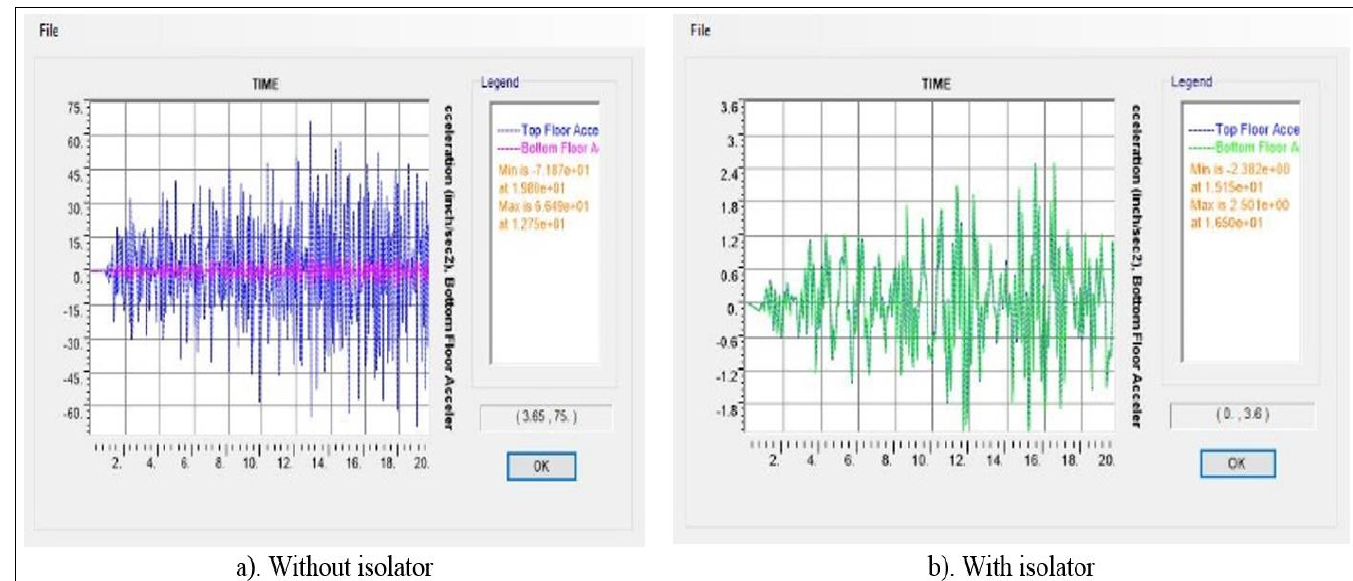
Figure 14: Top and bottom acceleration vs time curve (20